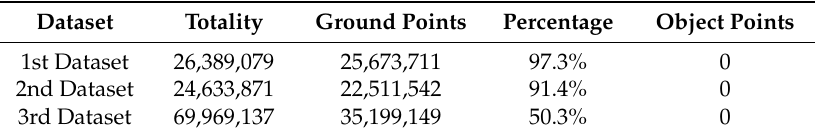
Table 4. The results of ground point removal in the three datasets.